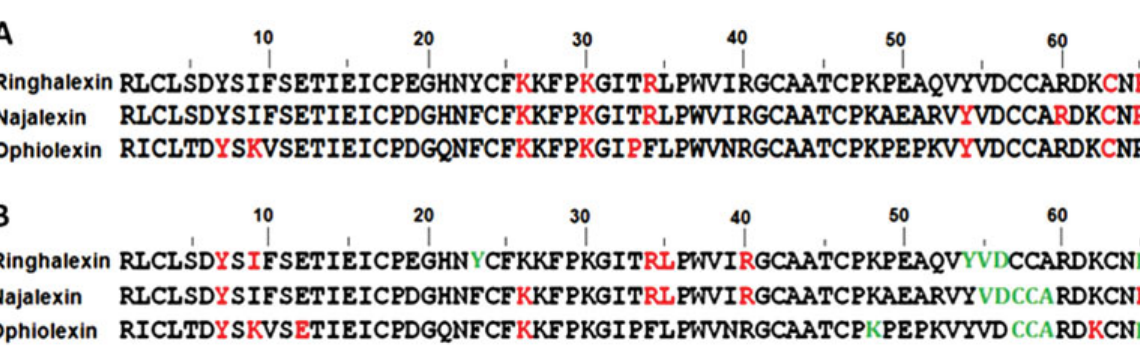
Fig. 6 Amino acid residues of ringhalexin, najalexin, and ophiolexin involved in interactions with the extrinsic tenase complex. The residues involved in interactions with ( A ) TF and ( B ) TF-FVIIa. The residues involved in interactions with TF and the heavy chain of FVIIa have been highlighted in red and green,